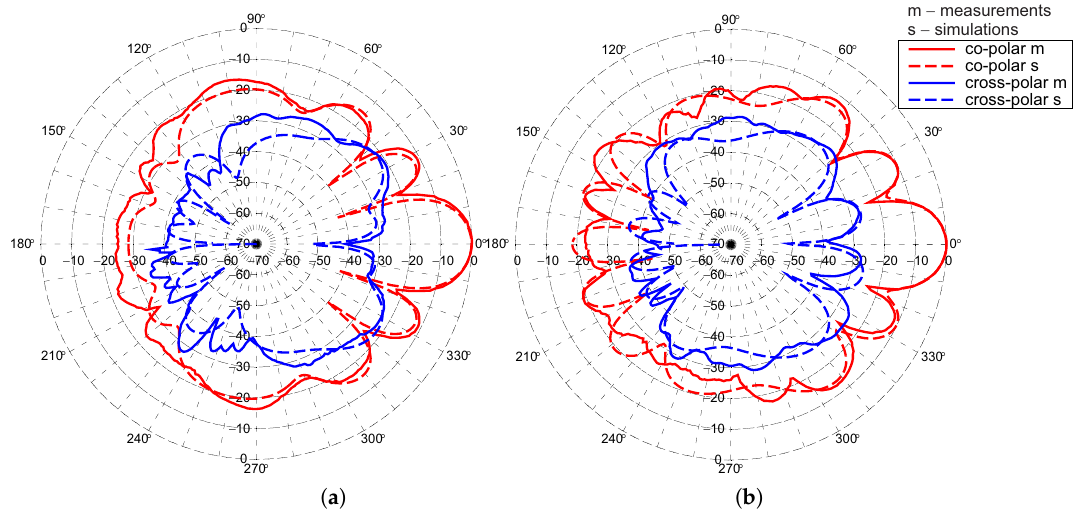
Figure 21. Normalised co-polar and cross-polar radiation patterns measured and simulated at 5.5 GHz on principal V-plane for: ( a ) port 1; ( b ) port 2.